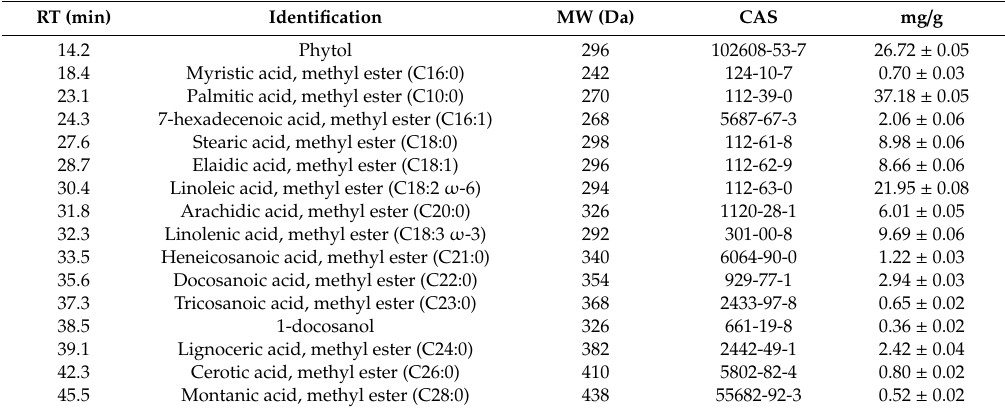
Table 3. constituents in G. diversifolia extract by GC-MS after